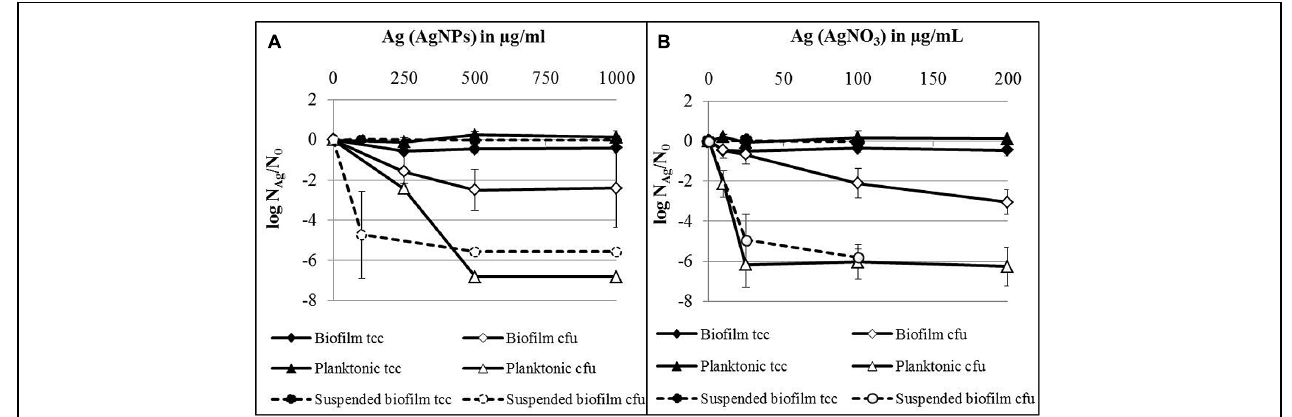
FIGURE 4 | Total cell counts (tcc) and colony counts (cfu) of established biofilms, suspended biofilms and planktonic bacteria of P. aeruginosa AdS in the presence of AgNPs (A) and AgNO 3 (B) in deionized water after 24 h at 36 ◦ C. N Ag : tcc or cfu per well in the presence of silver, N 0 : tcc or cfu in the absence of